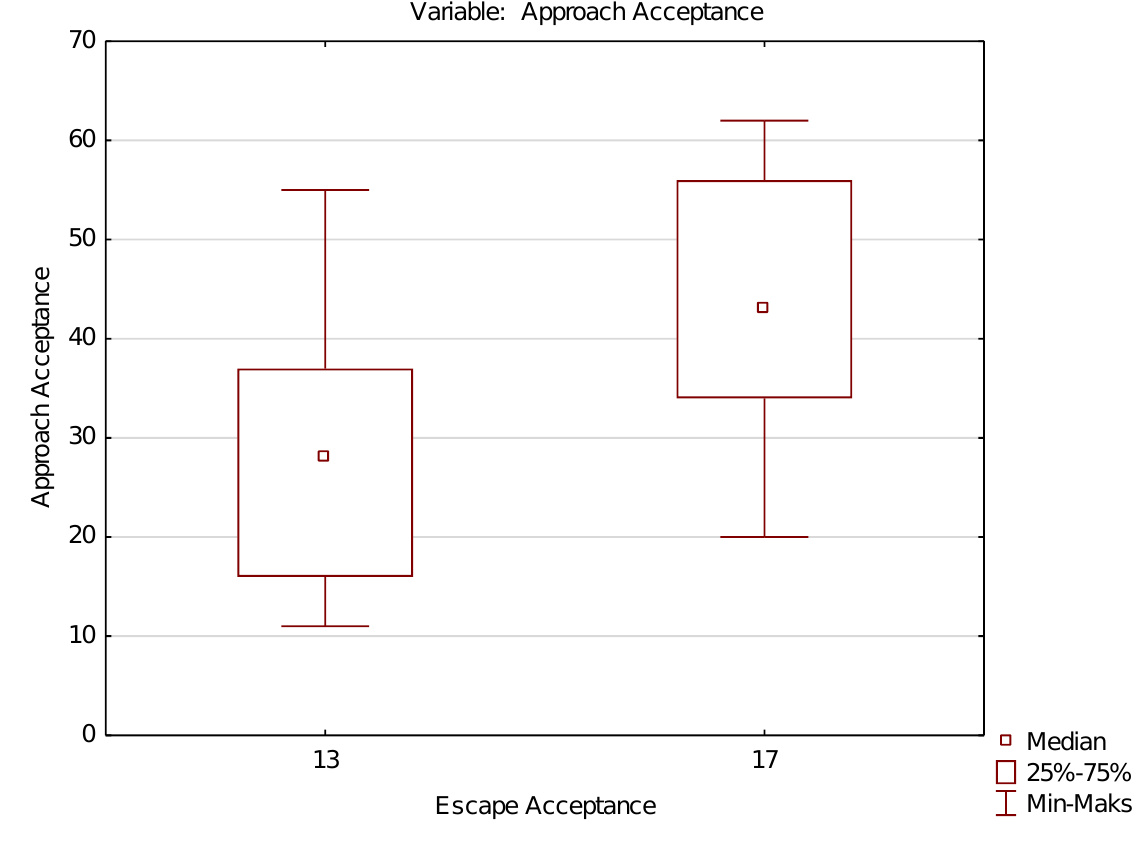
Figure 2. Box-whisker plot for AA and AE attitudes.